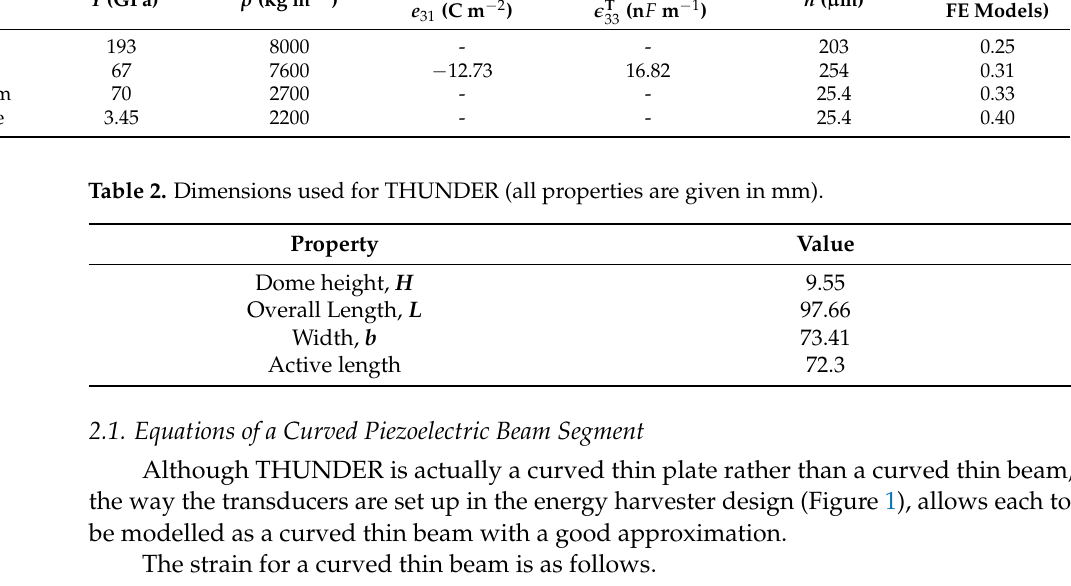
Table 1. Properties used for THUNDER [32].